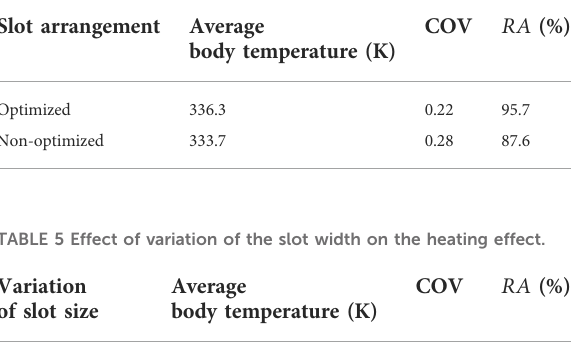
TABLE 4 Heating results of the optimized and non-optimized slot arrangements.